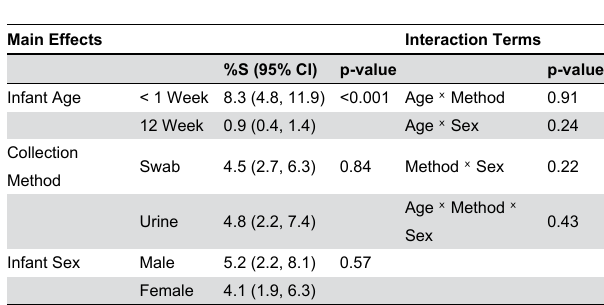
Table 2. The mean percent of superficial cells (%S) per specimen evaluated by the NIEHS Pathologist classified by infant age, sex and collection